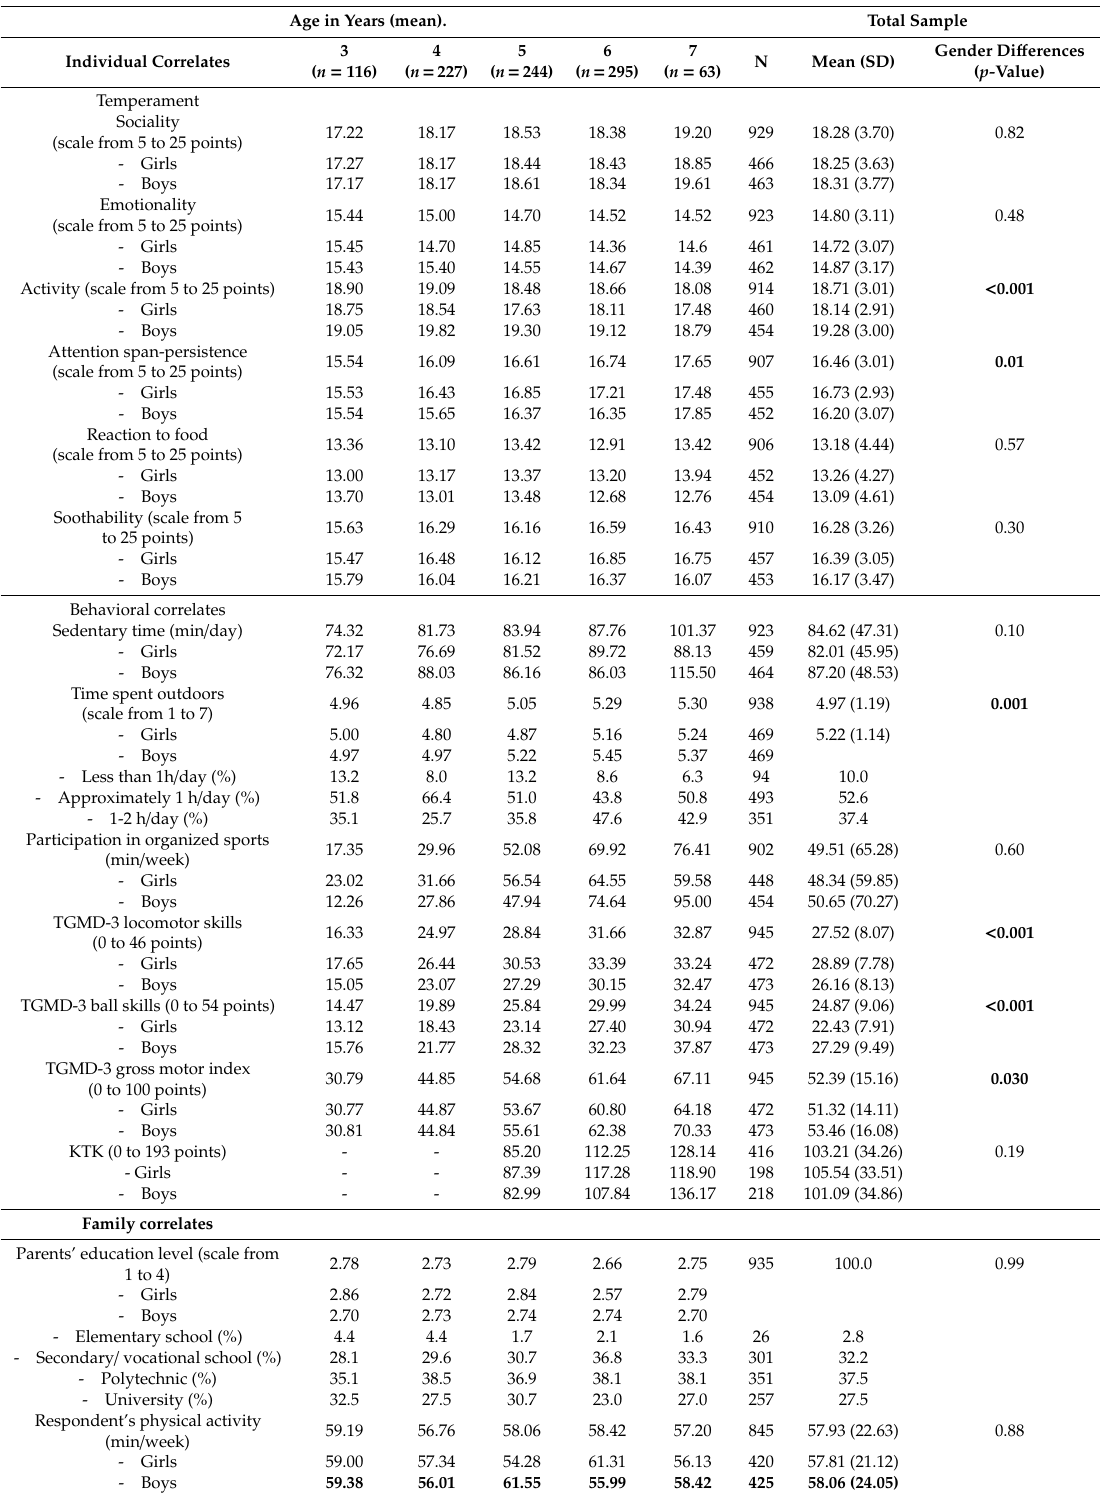
Table 1. Descriptive statistics of the study sample ( n =